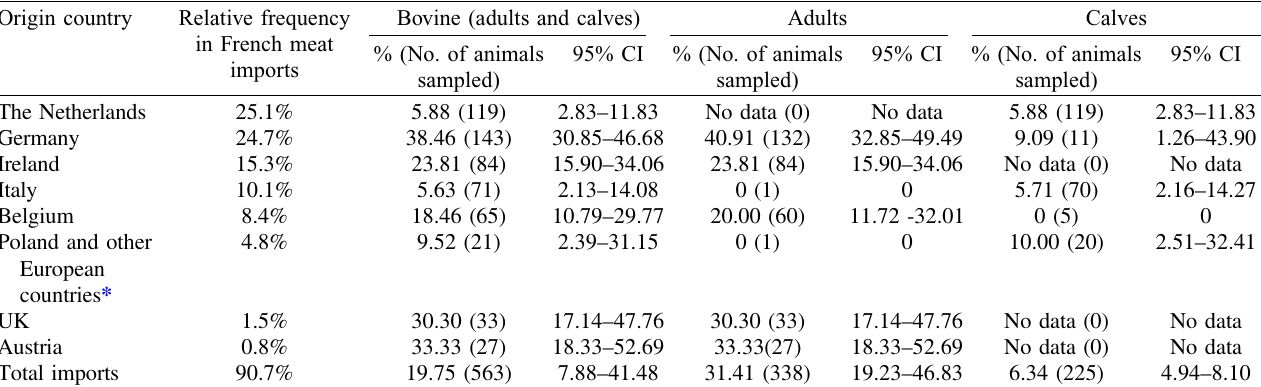
Table 7. Seroprevalence of Toxoplasma gondii infection (cut-off titer 6) in bovine meat imported at IFM Rungis (Ile de France). Origin